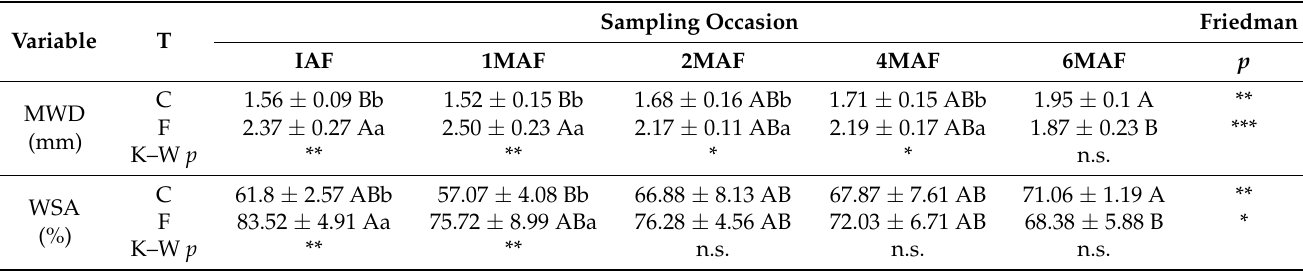
Table 2. Mean weight diameter (MWD) and water stable aggregates (WSA) of the soil in control (C) and fire (F) treatments (T) during the studied period (IAF, immediately after fire; MAF, months after fire) (mean ± standard deviation). Different letters indicate significant differences between sampling dates (uppercase letters) and treatments (lowercase letters). Kruskal–Wallis (K–W) (* p < 0.05, ** p < 0.01, *** p < 0.001, and n.s. non-significant at p < 0.05) results are shown for each comparison between treatments, and Friedman ANOVA between sampling